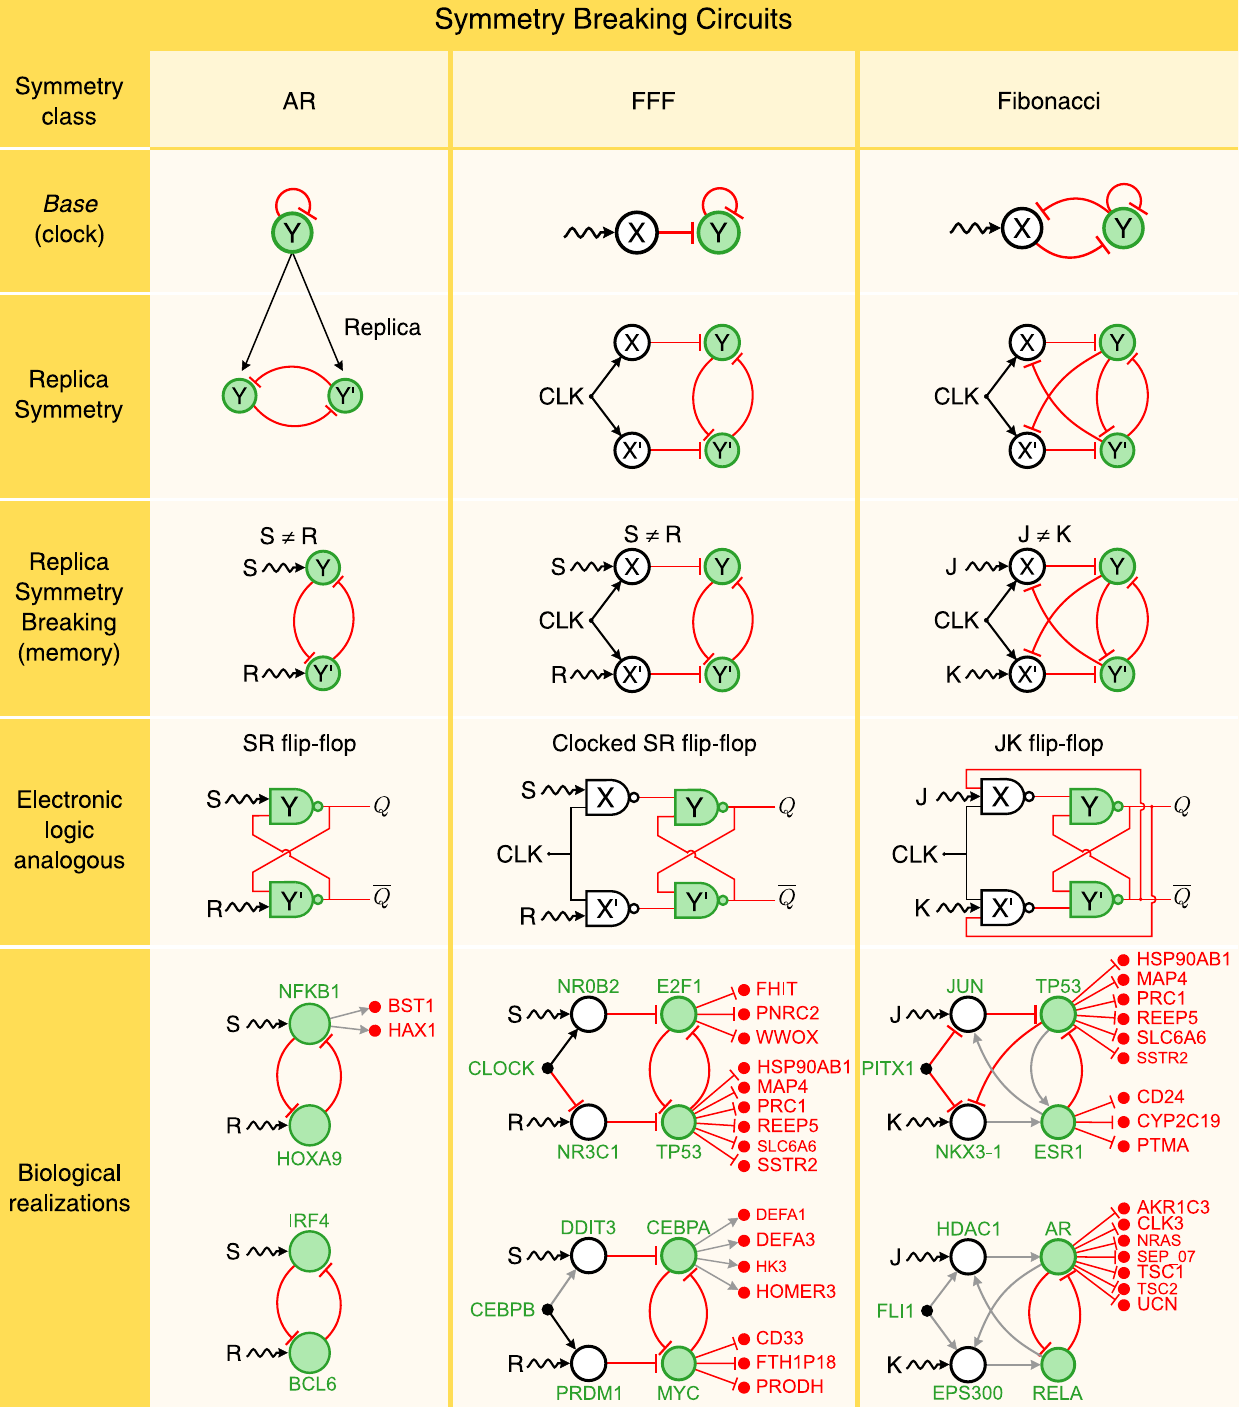
PLOS Computational Biology | https://doi.org/10.1371/journal.pcbi.1007776 June 17,